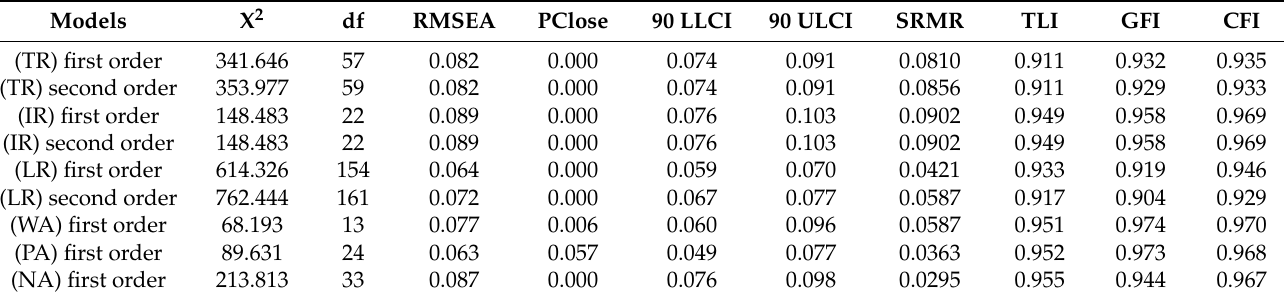
Table 1. Model adequacy and goodness of fit indices of the models tested using first- and second-order confirmatory factor analysis. Models